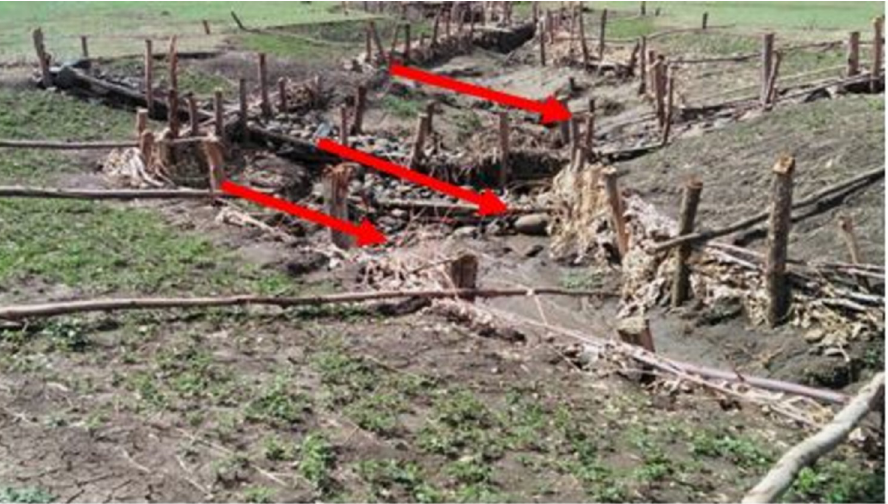
Fig 6. Brush wood check